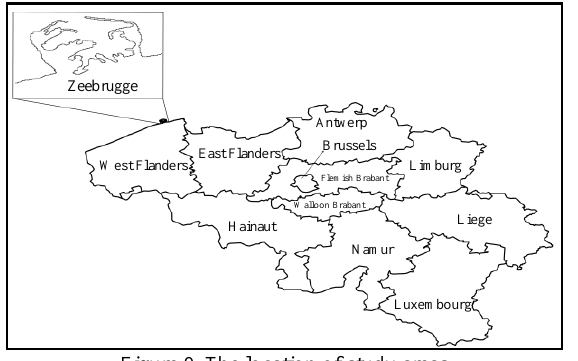
Figure 9. The location of study areas In order to validate of our proposed method, we compared the classification result with manual extracted trees from aerial ortho-images (Figure 10). For this purpose, the ortho-images